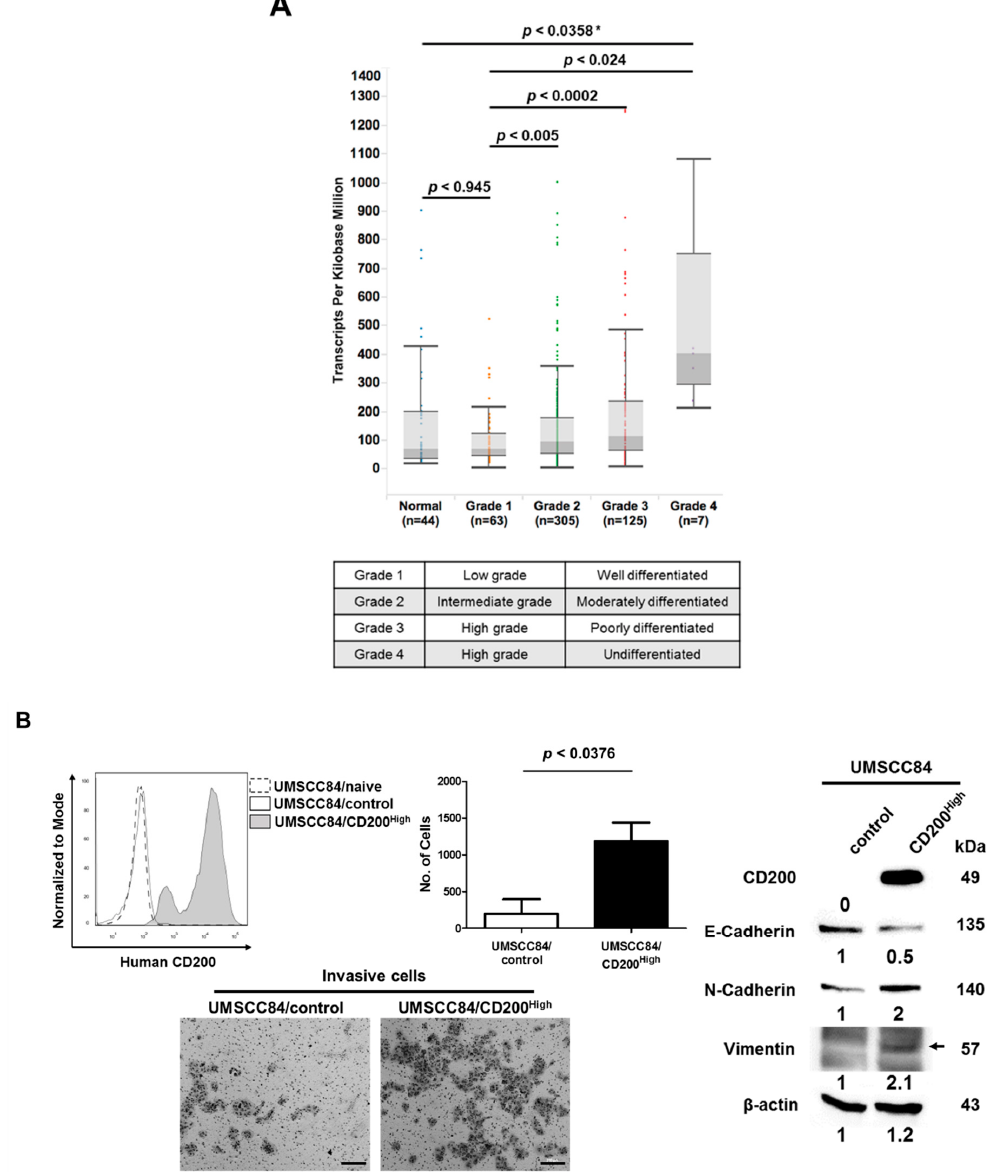
Figure 1. Cont. Figure 1.